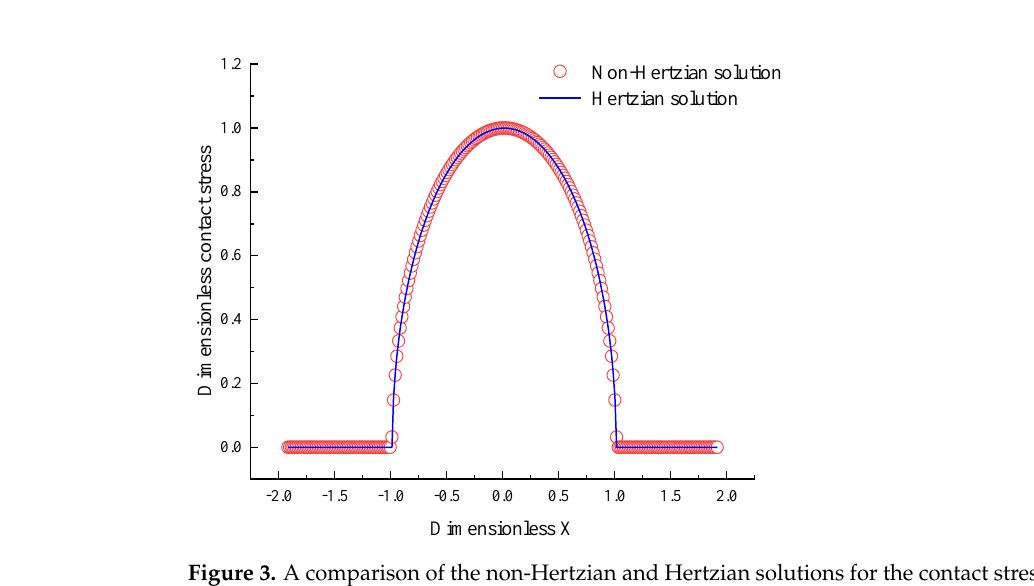
The lubricant film viscosity proposed by Roelands [26] is written as